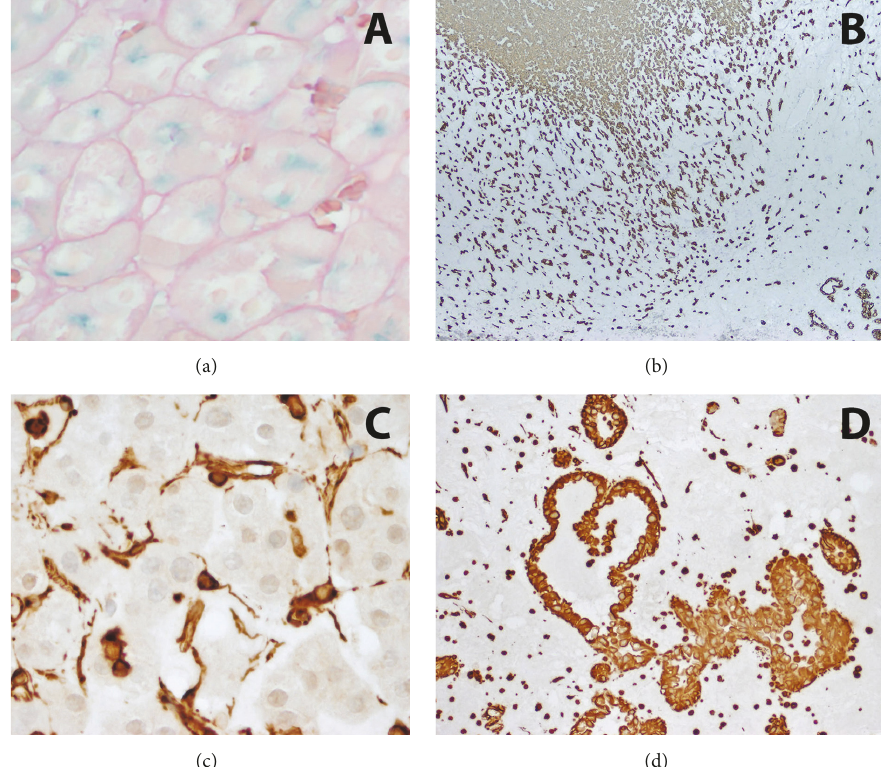
Figure 3: (a)-(d) Staining pattern of different tumor components: (a) positive intracellular staining with Hale colloidal iron in ChC. (b) CK7 stain highlighting both ChC and CDC components, at their emerging front. (c) While vimentin stain is negative in the ChC tumor cells, only highlighting vasculature, (d) it is diffusely positive in the CDC